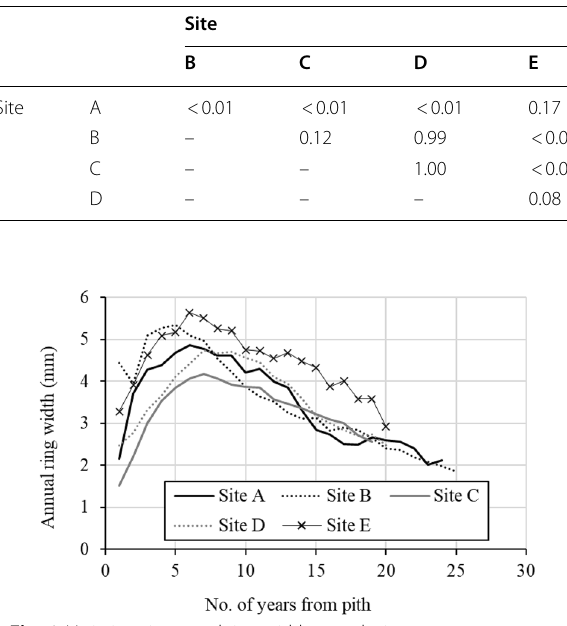
Fig. 6 Variations in annual ring width at each site